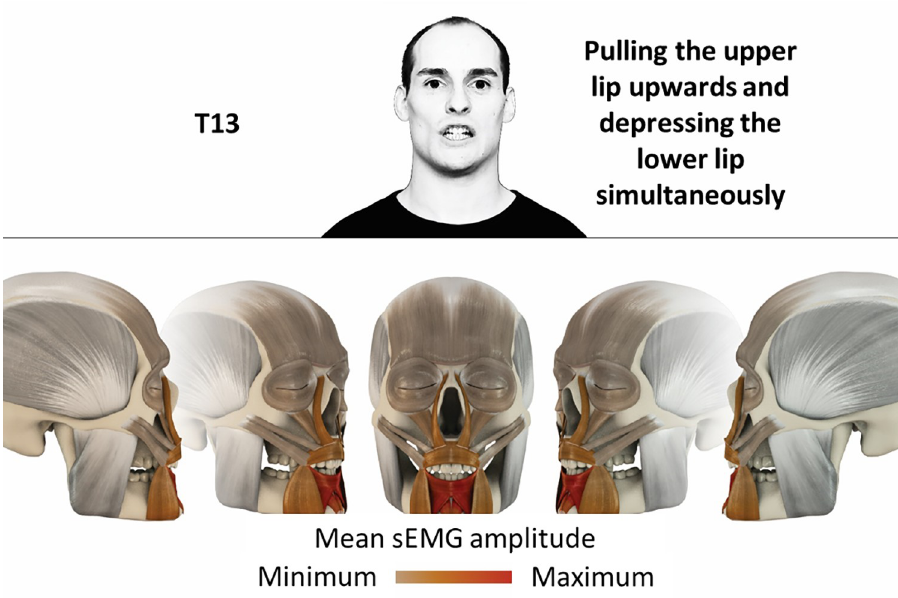
Fig 14. Color-coded facial muscle activation pattern of task T13. Pulling upper lip upwards and depressing lower lip simultaneously. Animation by Jonas Laustro¨er. Animation by Jonas Laustro¨er.